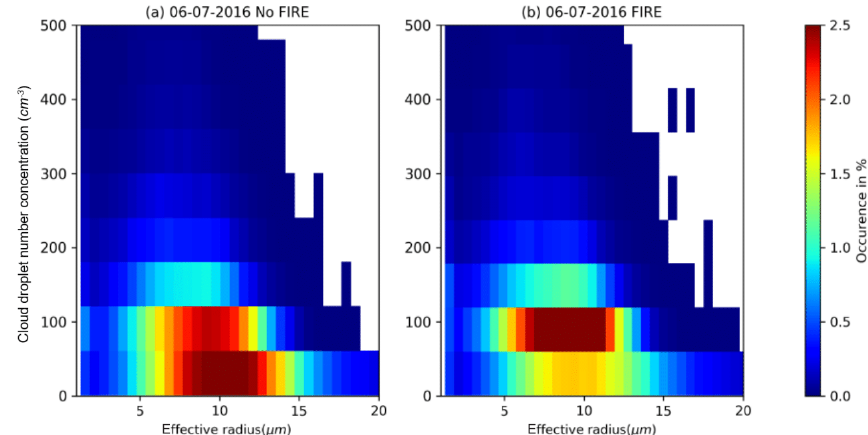
Figure 9. Two-dimensional histograms showing cloud properties in the NO FIRE (a) and FIRE (b) simulations conducted with COSMO-